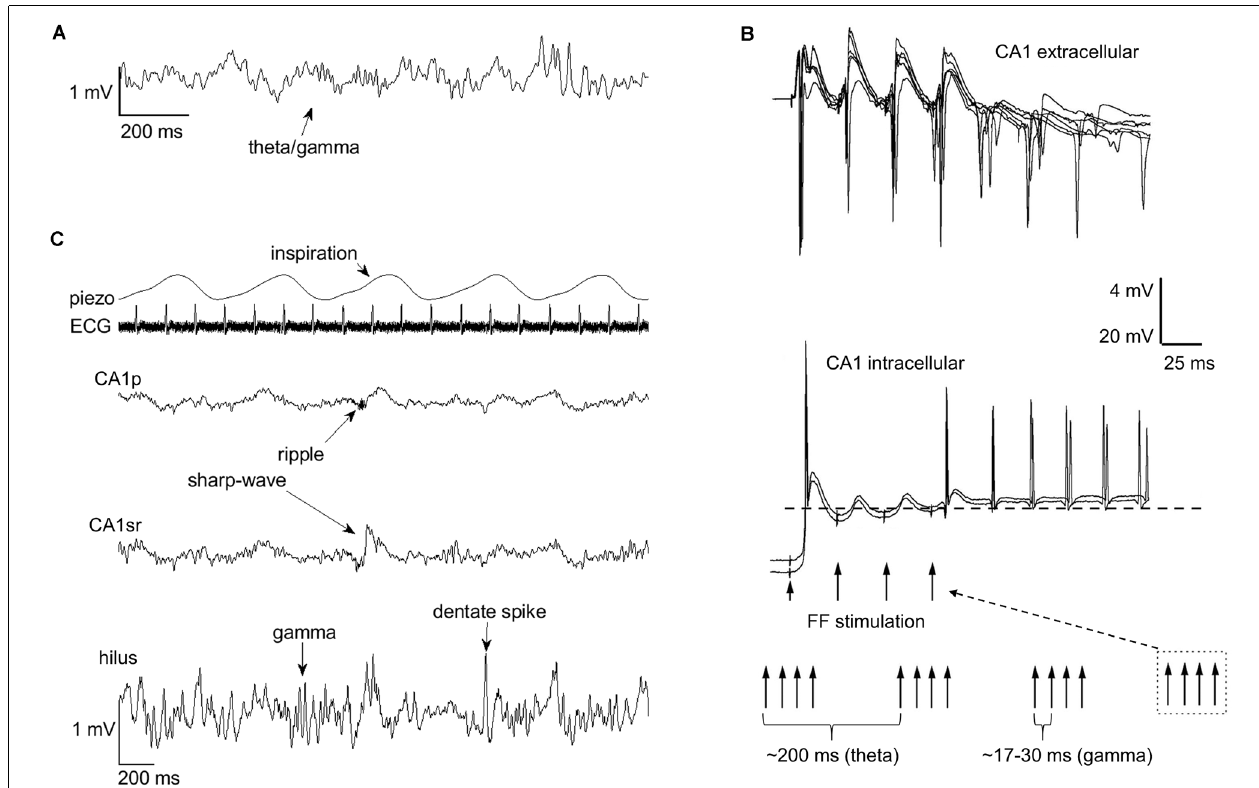
FIGURE 2 | Rhythms of the brain nest within each other and within the rhythmic fluctuations of bodily states. Nesting facilitates entrainment of oscillatory activity within the hippocampus. (A) Phase-amplitude coupling of theta and gamma band oscillations (respectively) in the hippocampus is a well-known example of endogenous nesting of rhythmic brain activity. (B) The graph is modified from Mikkonen et al. (2002). Rhythmic stimulation of the fimbria fornix (FF) in urethane anesthetized Wistar rats produced entrainment of CA1 activity at the stimulation frequency, but this effect was only evident if trains of gamma-band (30–60 Hz) stimulations were conducted at theta (3–7.5 Hz) frequency, mimicking the naturally occurring theta-gamma nested oscillations in the hippocampus. In addition to entrainment, a sustained rhythmic response retaining the stimulation gamma frequency, probably dependent on the resonant properties of CA1 interneurons and pyramidal cells, is also evident. (C) Rhythms of the brain also seem to nest within the rhythms of the body. The occurrence of hippocampal sharp-wave ripples, gamma bursts, and dentate spikes are paced by breathing (piezo). The example traces in (A,C) are from a urethane-anesthetized adult male Sprague-Dawley rat. ECG, electrocardiogram; CA1p, CA1 pyramidal cell layer; CA1sr, CA1 stratum